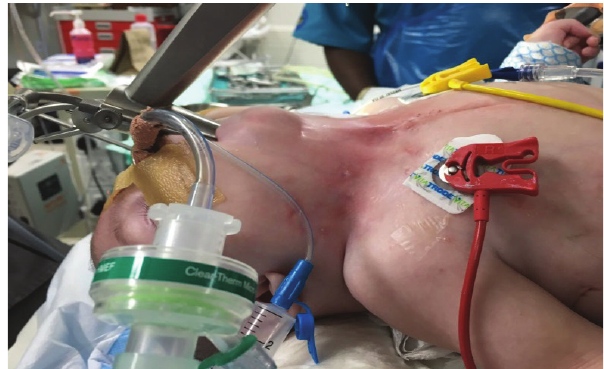
Figure 3. Patient for cardiac surgery with undiagnosed syndrome with features suggestive of difficult airway